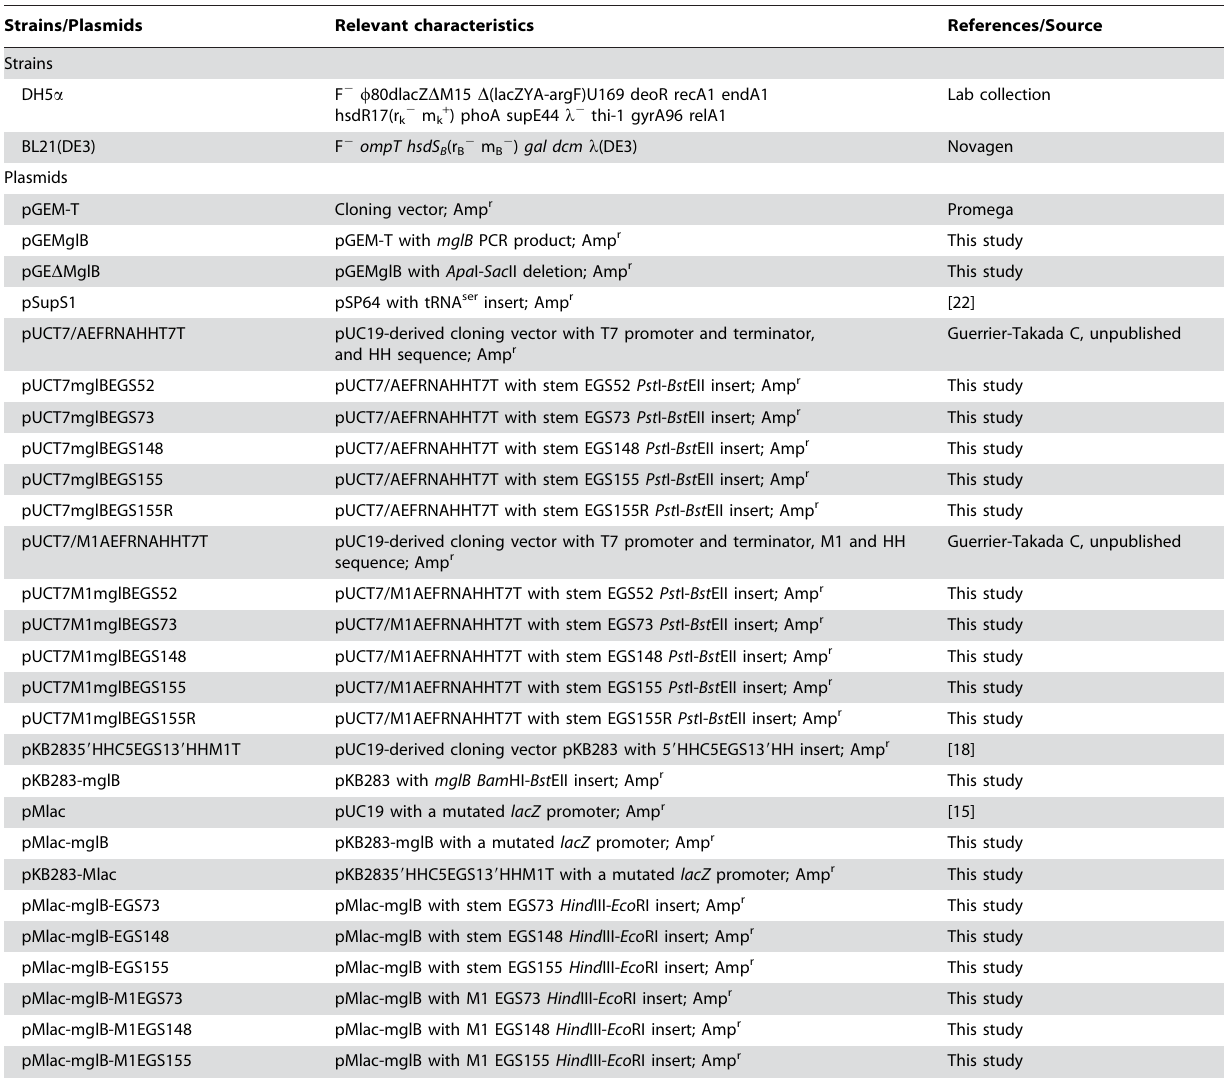
Table 1. Bacterial strains and